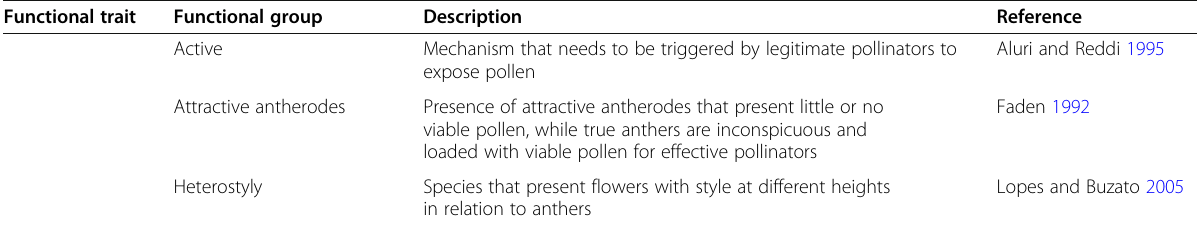
Table 2 Pollination-related functional traits and their respective functional groups (Continued) Functional